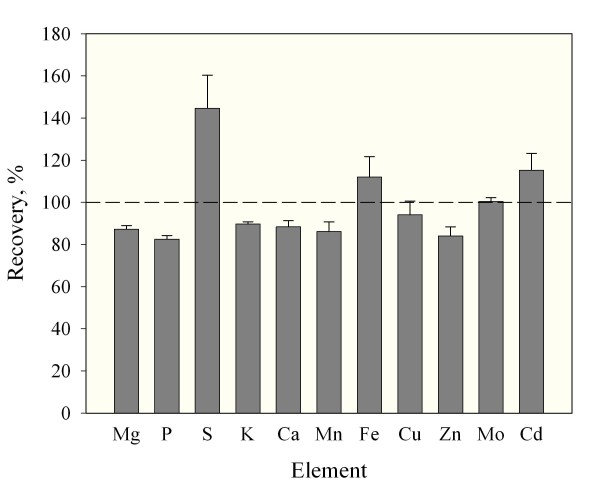
Accuracy of elemental concentrations measured by ICP-MS on 1 mg micro-scale digested Arabidopsis seeds (~50 seeds) compared to the corresponding concentrations in a larger seed batch of 20 mg (~1000 seeds). Values are means + SE (n = 4).